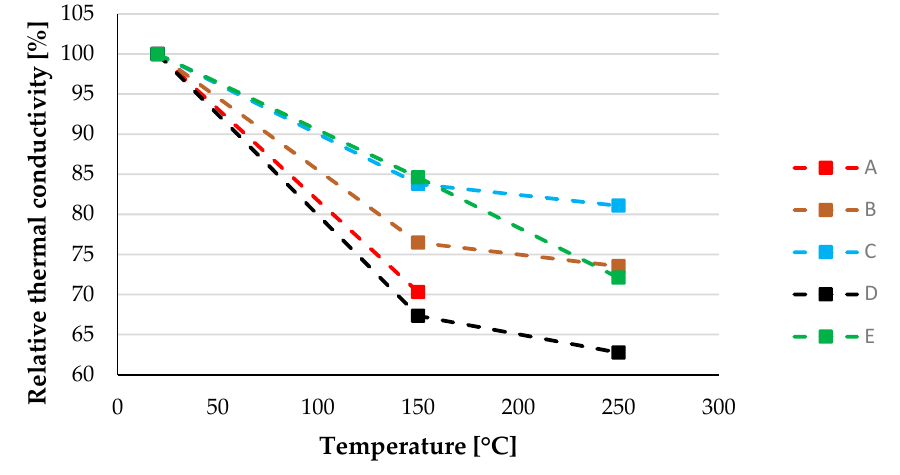
Figure 7. Thermal conductivity coefficient (%) vs. exposure temperature. Table 7. Thermal conductivity coefficient (average) vs. exposure temperature.